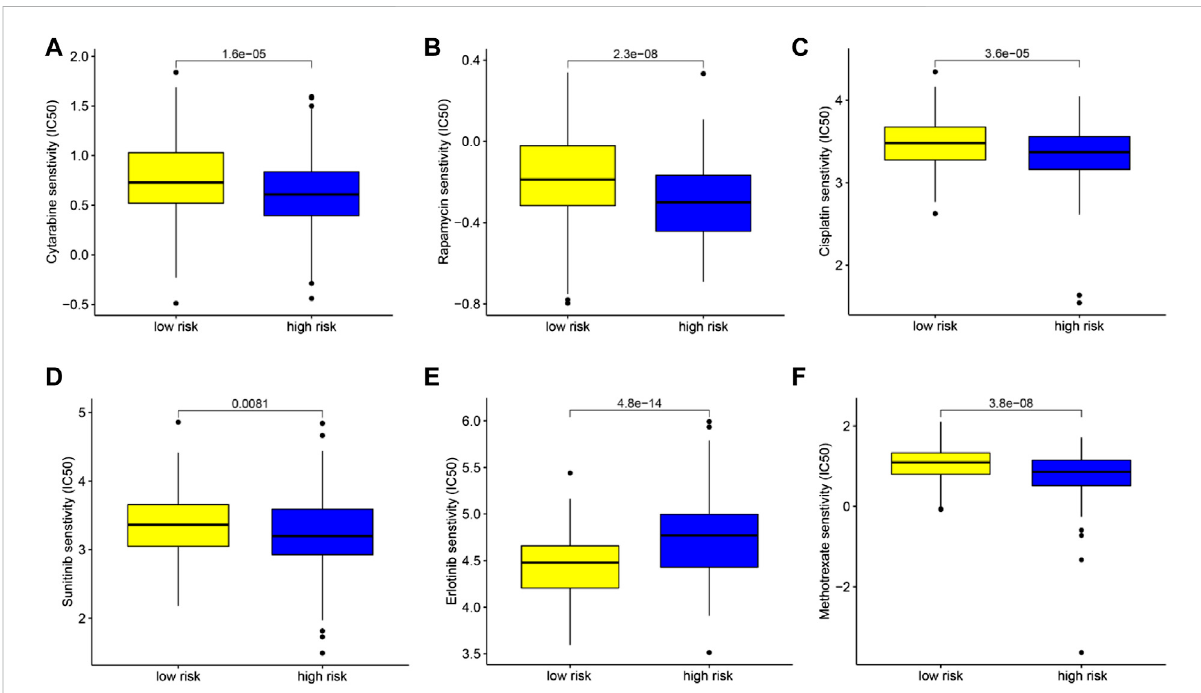
FIGURE 10 Chemotherapeutic drug sensitivity analysis based on TIMSig. (A – F) Comparison of the IC50 levels (cytarabine, rapamycin, cisplatin, sunitinib, erlotinib, and methotrexate) with different groups of TIMSig in the TCGA